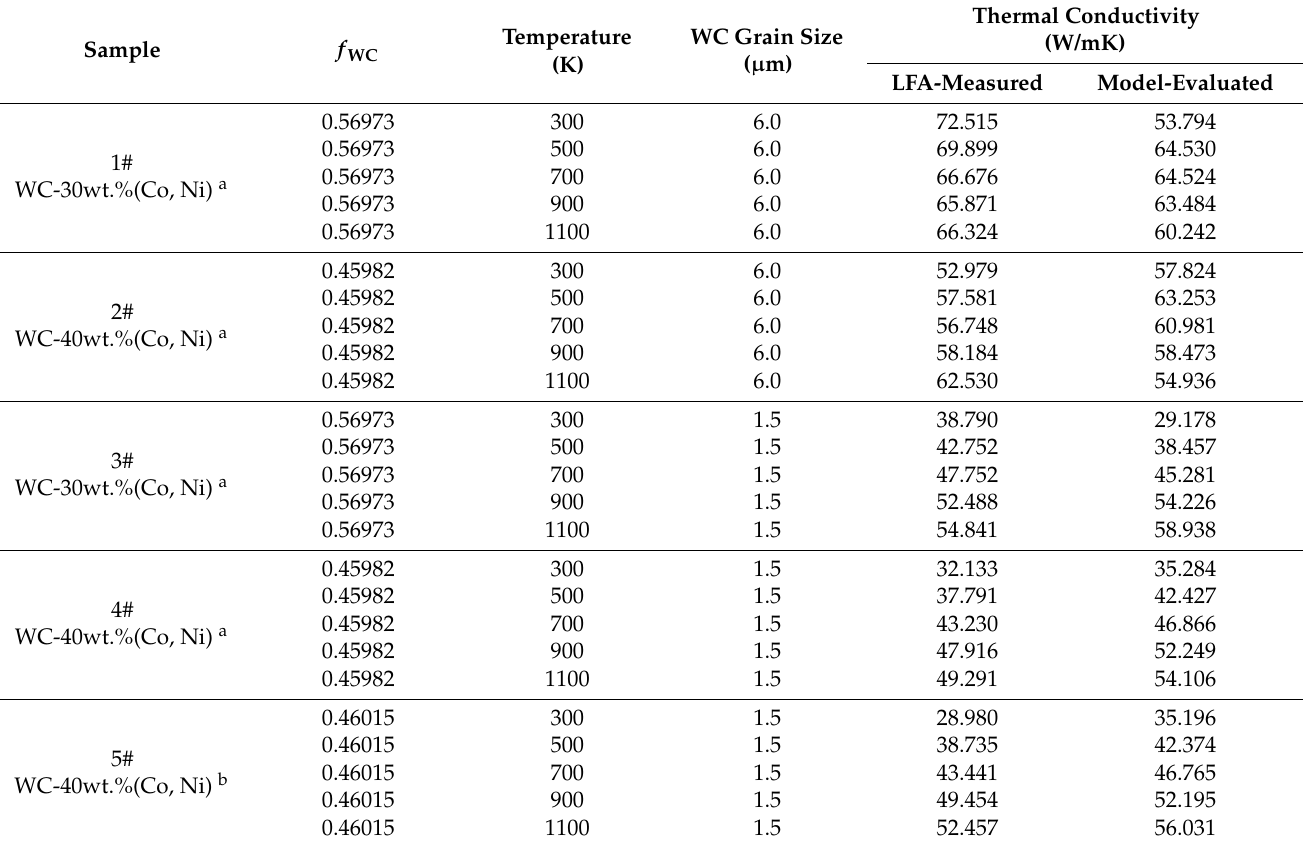
Table 1. Measured thermal conductivity for each prepared two-phase WC-Co-Ni sample, in compari- son with the model-evaluated ones.